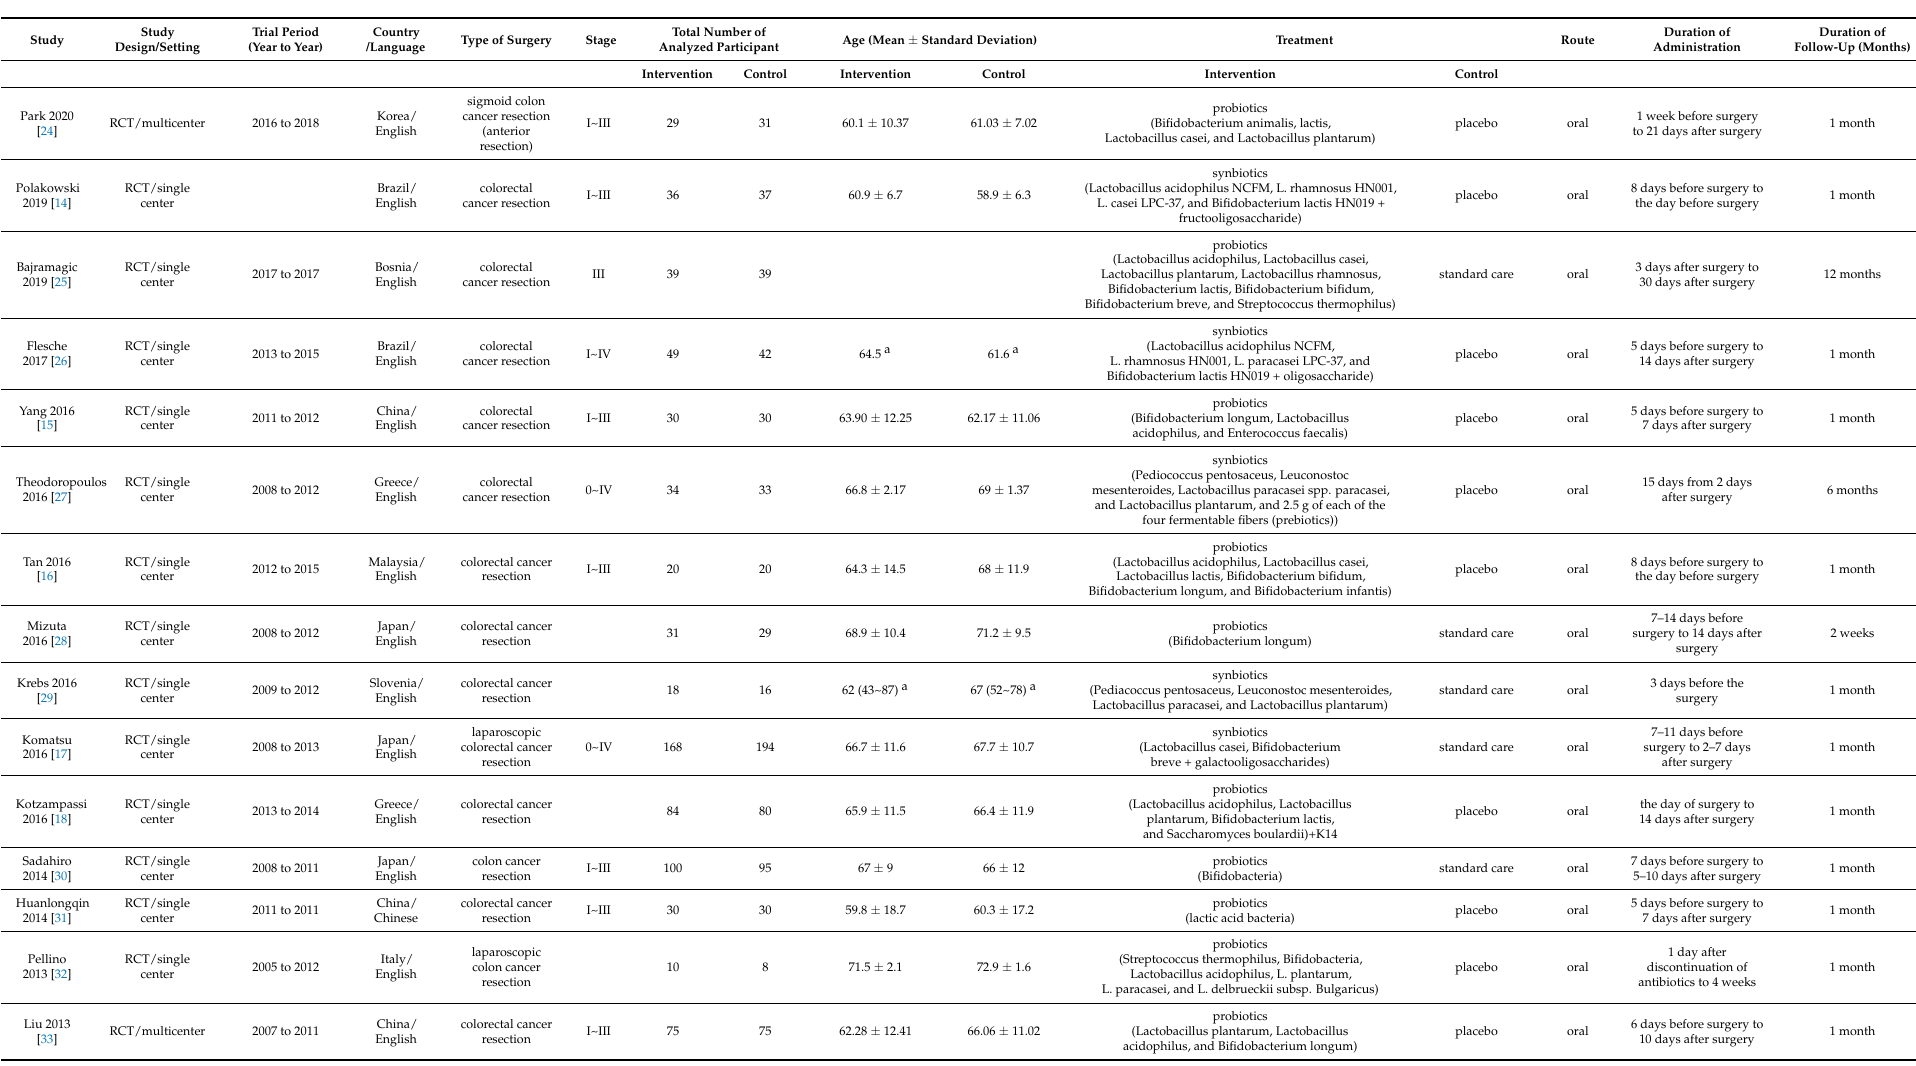
Table 1. Baseline characteristics of included